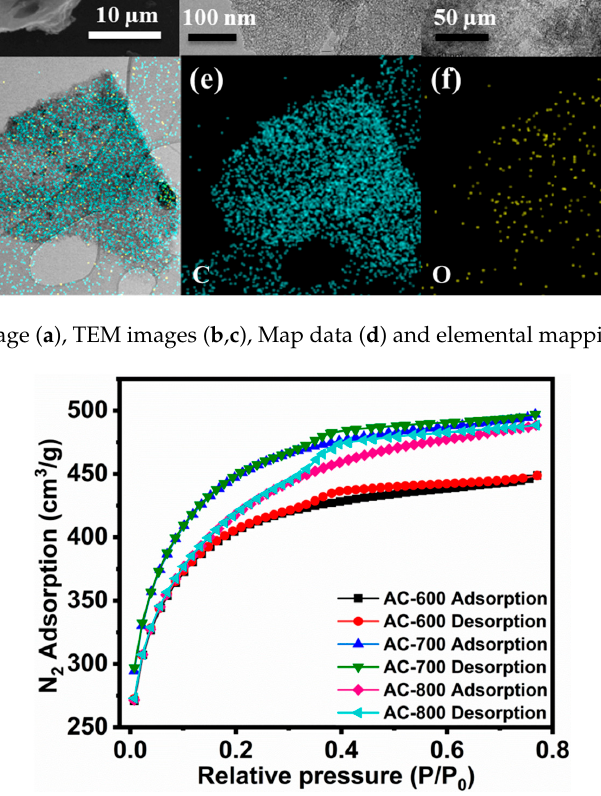
Figure 2. N 2 Adsorption-desorption isotherms of activated carbons.